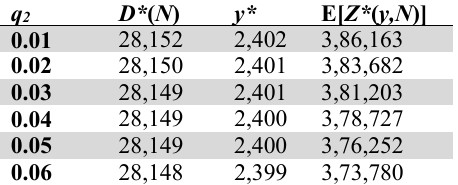
Impact of q 2 on optimal production policy Impact of r on optimal production